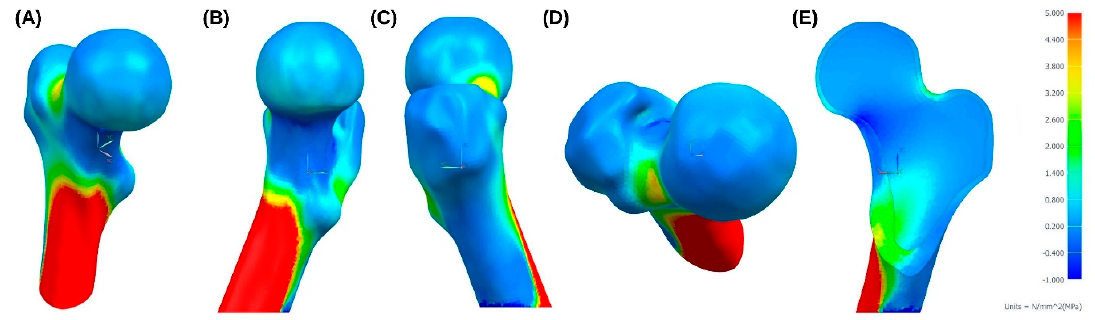
Figure 11. ( A ) Isometric, ( B ) right, ( C ) left, ( D ) top and ( E ) back view of maximum principal stress in proximal femur when applying standing-up loads.